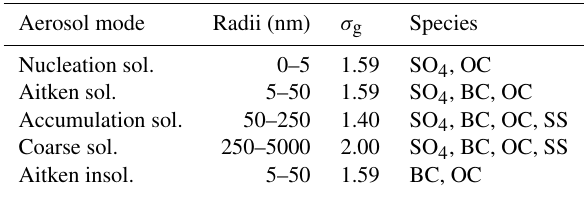
Table 4. The aerosol size distribution in GLOMAP-mode including aerosol modes represented and the range of radii that these include, their geometric standard deviation, and aerosol species contributing to each mode. Species represented are sulfate, black carbon, organic carbon and sea salt. Aerosol mode Radii (nm) σ g Species Nucleation sol. 0–5 1.59 SO 4 , OC Aitken sol. 5–50 1.59 SO 4 , BC, OC Accumulation sol. 50–250 1.40 SO 4 , BC, OC, SS Coarse sol. 250–5000 2.00 SO 4 , BC, OC, SS Aitken insol. 5–50 1.59 BC,